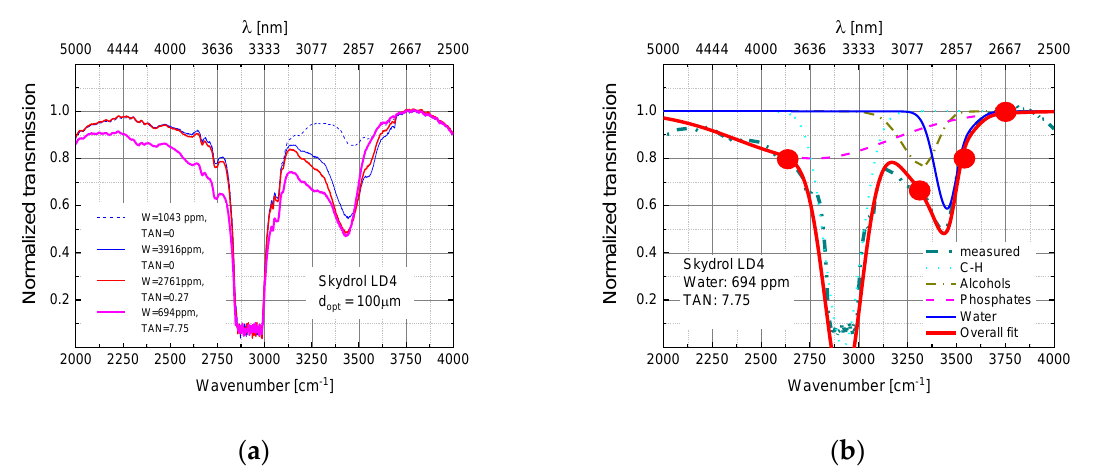
Figure 5. ( a ) FTIR spectra of Skydrol LD4 samples in different states of water contamination (blue) and fluid degradation (red, magenta) [10,11]. ( b ) Deconvolution of FTIR spectra into C-H, phosphate- and water-related spectral features. Red circles denote sensor interrogation points used in the sensor prototype described further below [10,11].